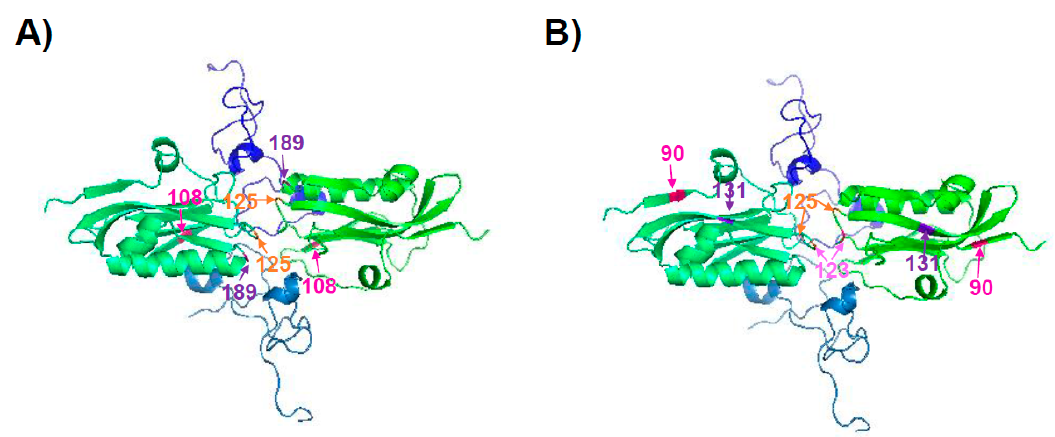
Figure 3. The tridimensional structure of the IAV NS1 ED coupled to the F2/F3 domain of CPSF30. A/Udorn/72 H3N2 strain NS1 ED bound to the F2/F3 fragment of the human CPSF30 was previously crystalized [108] (protein data bank (PDB) entry 2RHK). Colors were included using the MacPyMOL Molecular Graphics system (pymol.org). Each monomer of the NS1 ED is represented in green colors. Monomers of the F2/F3 fragment of the human CPSF30 are represented in blue colors. The artificially introduced NS1 amino acid residues 108, 125, and 189 restoring NS1–CPSF0 binding ( A ) [125], and the residues 90, 123, 125, and 131 found in naturally circulating pH1N1 viruses ( B ) [126], are indicated in reddish colors (orange, purple, and pink). Figure adapted from [126].